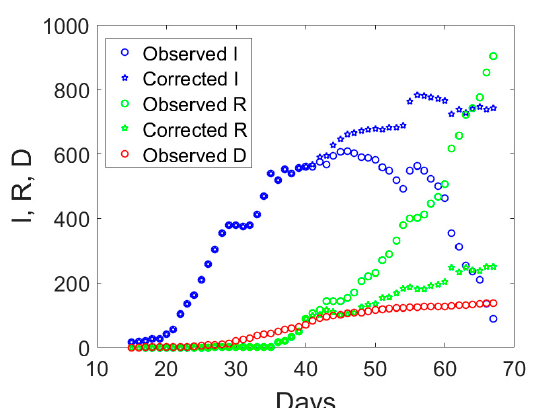
Figure 3. Observed compartments (circles) in Valle d’Aosta and proposed corrected values based on the ratio between the daily total number of medical swabs over the number of actual infectious individuals